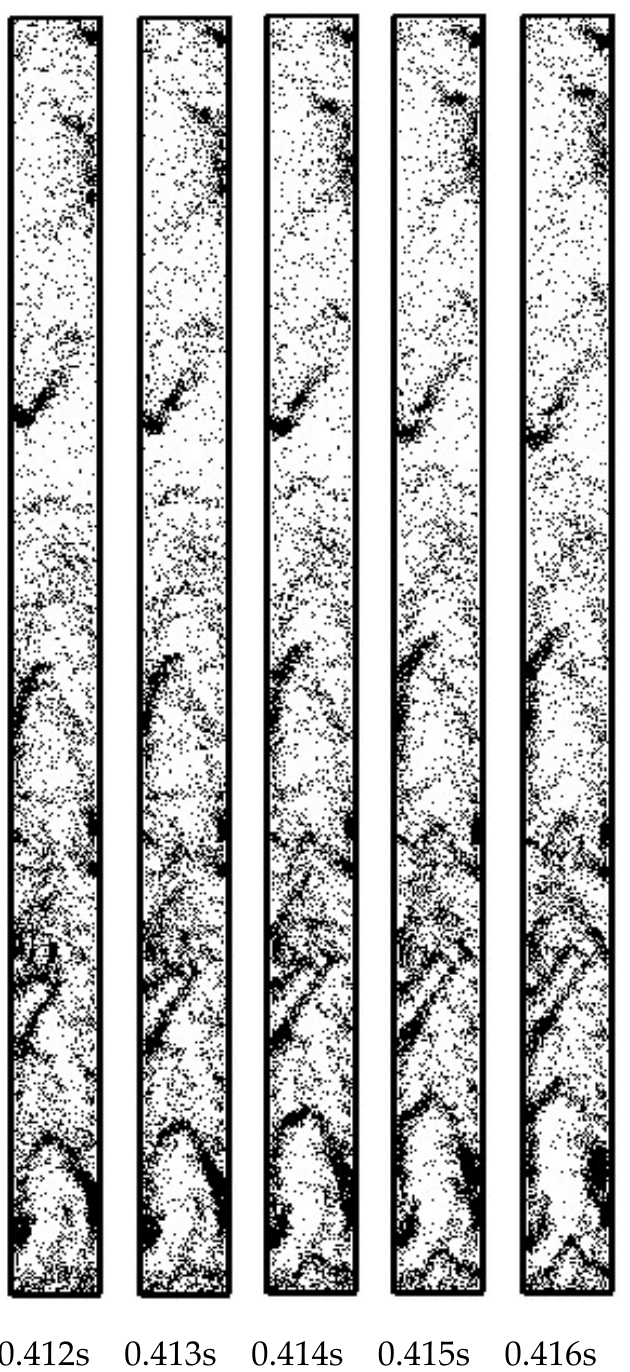
Figure 4. Particle locations at 0.018 s, with large t r = 295.0